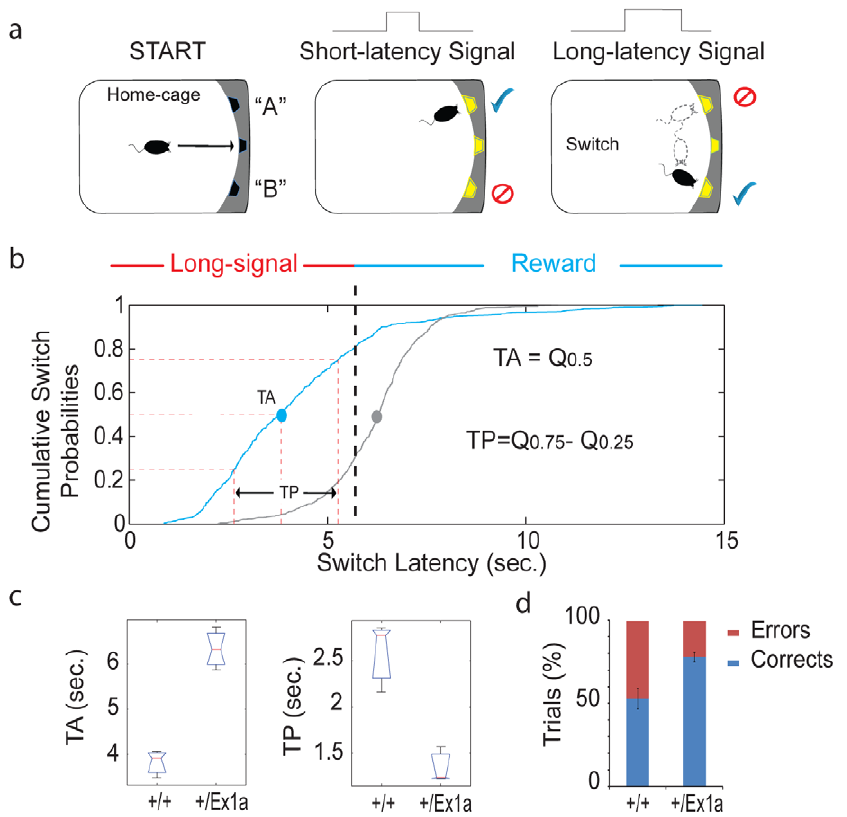
Figure 5. Cognitive performance in Exon 1A mice and littermate controls. (a) A schematic representation of the ‘‘switch task’’ in which a mouse self-initiates the trial (‘‘START’’) and receives a reward according to the duration of the signal (‘‘short-latency’’ versus ‘‘long-latency’’) and the location (‘‘A’’ or ‘‘B’’). (b) The cumulative distribution of all switch latencies (the time at which the mouse stops nose poking in the short-location and moves to the long location) for all long-signal trials are reported for the + /Ex1a mice and their littermate controls. (c) From the above cumulative distribution of the switch latencies we have derived the Time Accuracy (TA), as the median (Q 0.5 ), and the Time Precision (TP), as the difference of the third and first inter-quartiles (Q 0.75 2 Q 0.25 ), similar to what is described in [22]. Box-plots of TAs (the median values for each subject) and TPs (the inter- quartiles) are shown as well as (d) the percentage of correct versus error trials for the whole experiment. The correct/error trials graph refers only to the ‘‘Switch’’ condition, however, the same trend was observed in the ‘‘Probes’’